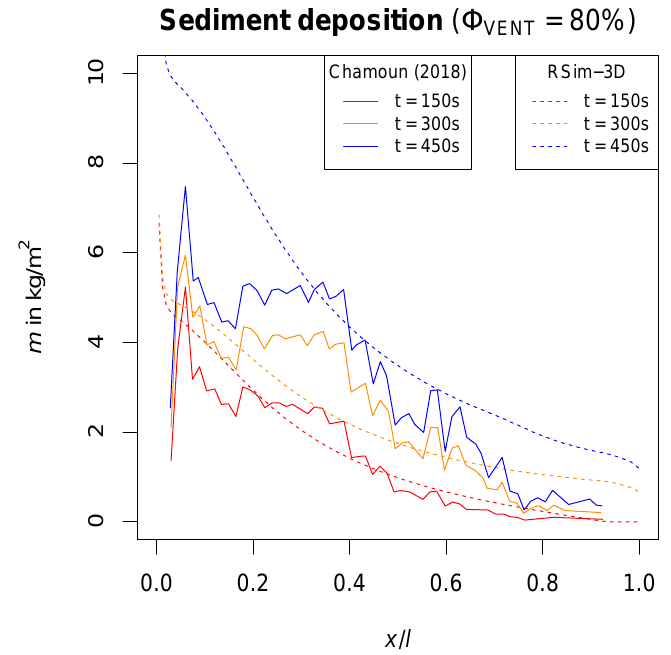
Figure 9. Sediment deposition along the channel at a venting degree of φ VENT =